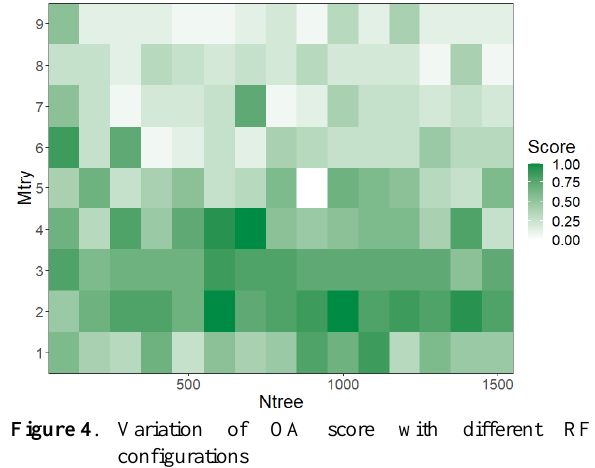
Figure 4 . Variation of OA score with different RF configurations